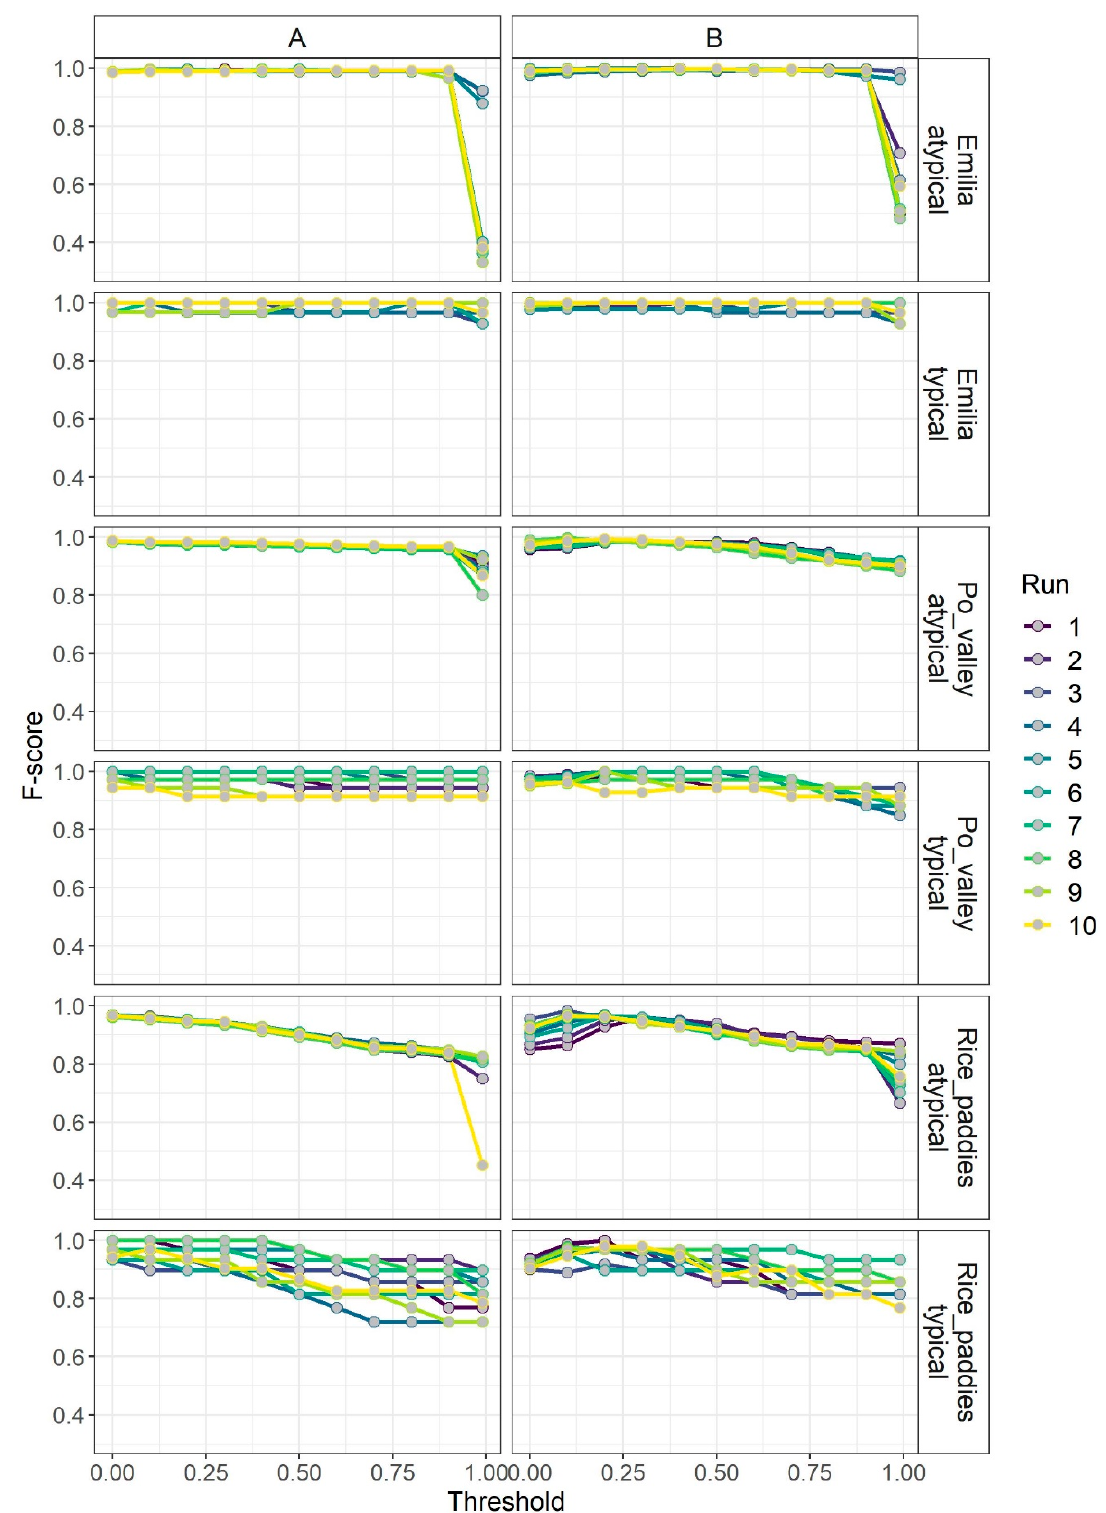
Figure 8. F-score diagrams on the three ROIs in the typical and atypical 10-fold cross validations using soft constraints defined by experts A and B. Parameters used for k-fold cross validations: k = 10, learning rate = 0.5 and number of epochs = 500.